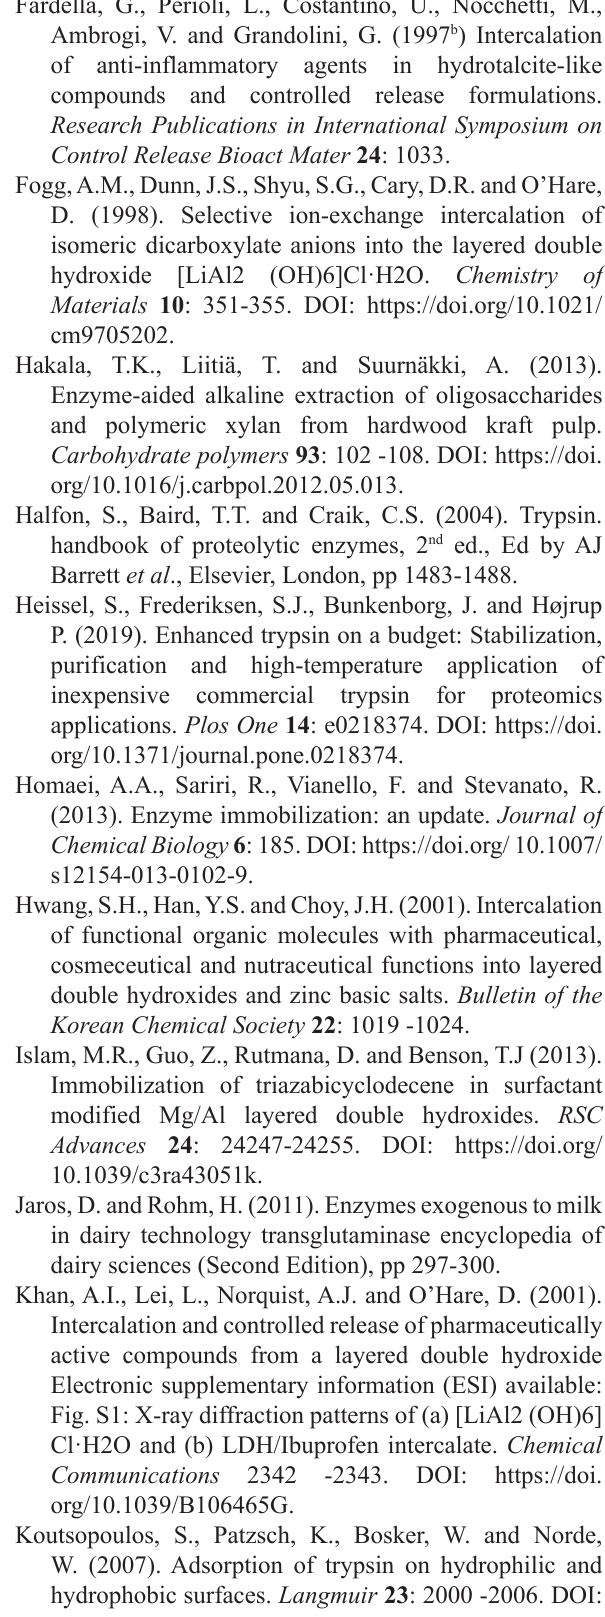
Electronic supplementary information (ESI) available: Fig. S1: X-ray diffraction patterns of (a) [LiAl2 (OH)6] Cl·H2O and (b) LDH/Ibuprofen intercalate.